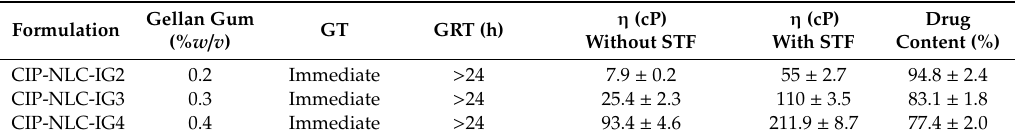
Table 5. Rheological evaluation of CIP-NLC-IG with di ff erent gellan gum concentrations (mean ± SD, n =